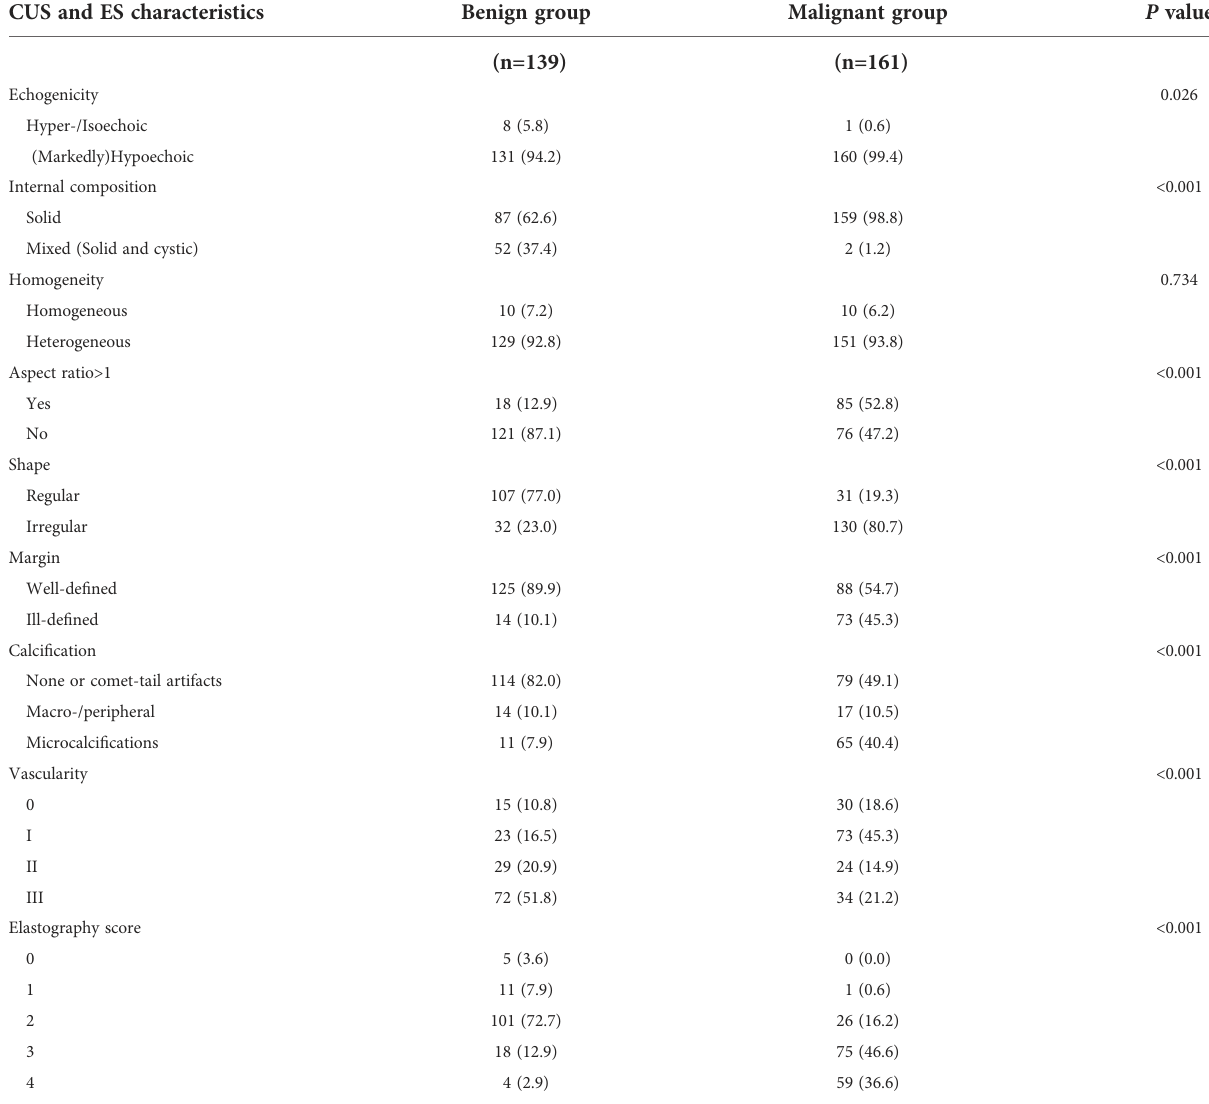
TABLE 3 Conventional ultrasound and elastography (ES) characteristics of benign and malignant thyroid nodules in the training